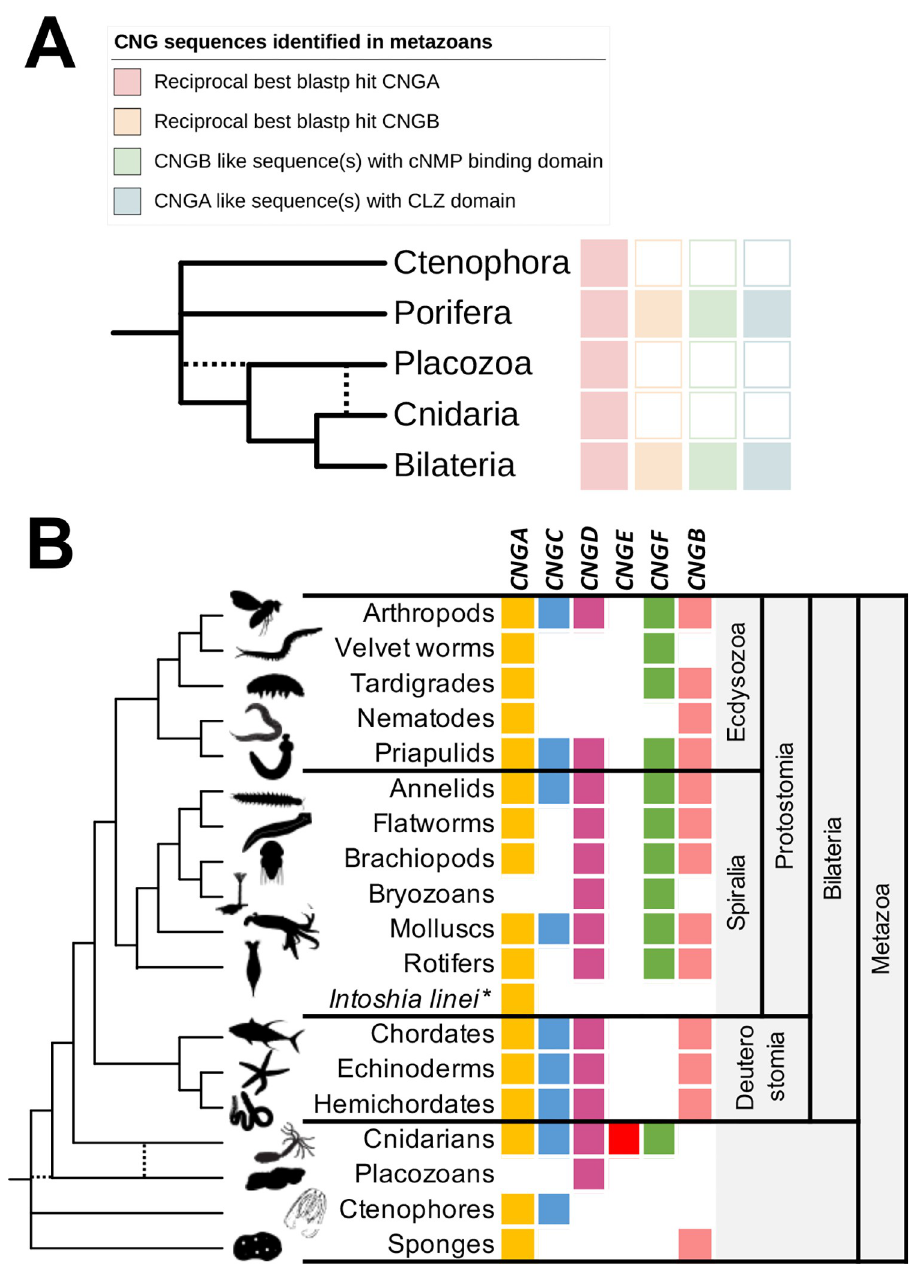
Fig 3. CNGA and CNGB type genes in metazoans. A) Summary of BLASTP searches for CNG genes in metazoans after PfamA screening for CNG channel domains. The results show that only animal groups that have CNGA genes with a CLZ domain also have genes of the CNGB type. Dotted lines represent alternative branching for the placozoa lineage. B) Presence or absence of genes of the CNGA and the CNGA-like subtypes in the different animal groups included in the analysis. The results show that there have been several lineage specific losses within protostomes and deuterostomes. The Bilaterian ancestor most likely had CNGA, CNGC, CNGD and CNGF genes. The ancestor of deuterostomes lost the CNGF gene. The only lineage that has genes of all CNGA-like subtypes is Cnidarians. Intoshia linei is labelled with an asterix due to its uncertain position. Silhouettes were retrieved from phylopic.org and are all dedicated to the public domain.